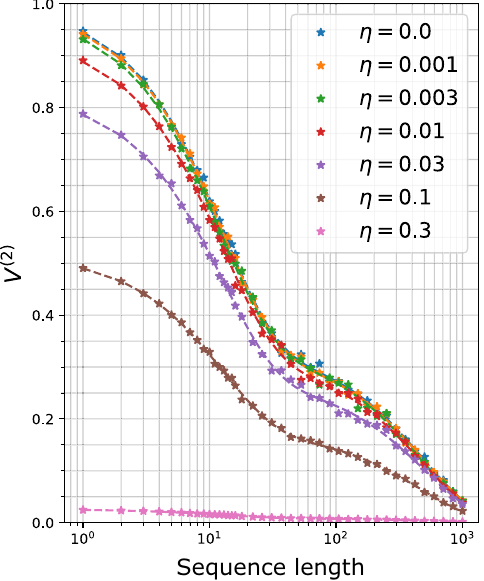
FIG. 7. Numerical results for the single-qubit 2-RB with SPAM errors for p = q = 0.02. We have taken 1000 measure- ments and 1000 random unitary sequences. The dots represent the numerically obtained data and the dashed lines are the fitting curves.